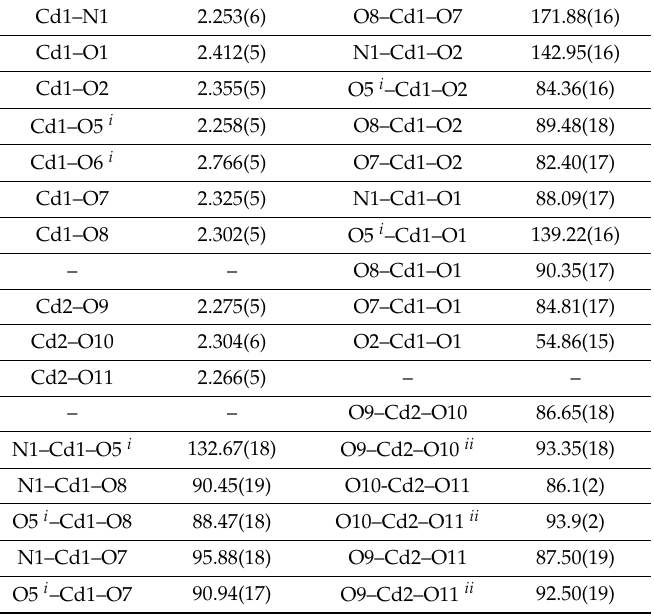
Table 1. Selected bond lengths [Å] and angles [ ˝ ] in 1 .